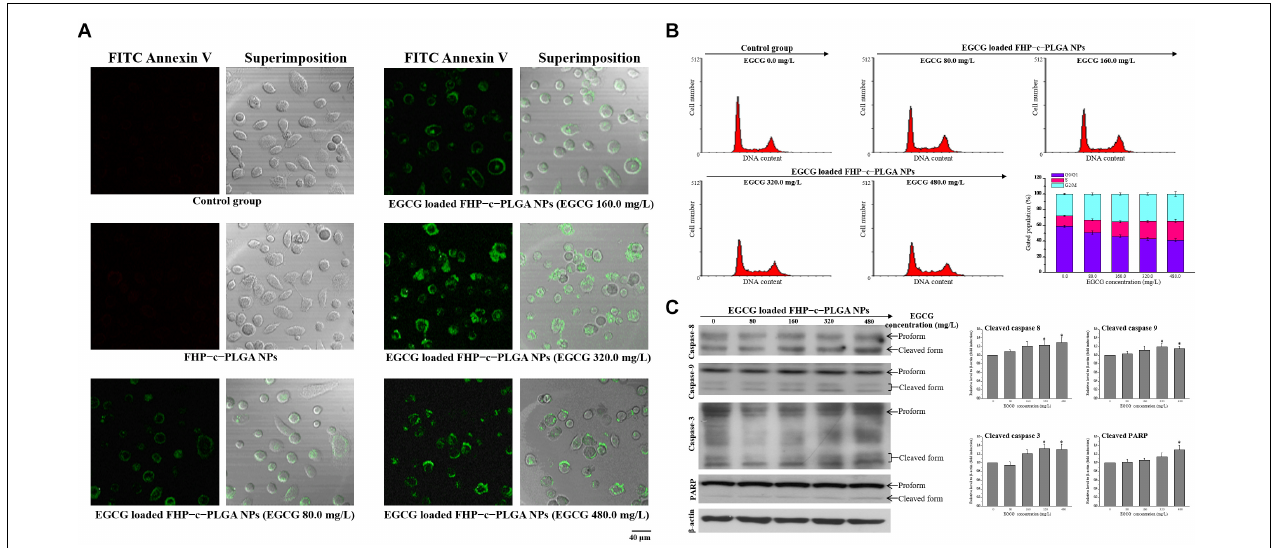
FIGURE 5 | (A) Fluorescence detection of apoptotic prostate cancer cells (PC3) cells after treatment with FHP–c–PLGA NPs loaded with different epigallocatechin gallate (EGCG) concentrations. Controls were labeled with FITC-Annexin V and analyzed using a con-focal laser scanning microscope. (B) The proportions of cells in the G0/G1, S, and G2/M phases after treatment with EGCG-loaded FHP-c-PLGA NPs are indicated. The cells were stained with propidium iodide, and the cell cycle distribution was analyzed using flow cytometry. (C) Western blotting analysis of apoptosis-related caspase-8, -9, -3, and poly (ADP-ribose) polymerase (PARP) in PC3 cells after incubation with EGCG-loaded FHP–c–PLGA NPs, and β -actin was used as an internal control. Asterisk * represents statistically a significant difference of p value < 0.05, as compared with the without sample treatment group. TABLE 3 | Effect of different PLGA/IO concentrations on particle sizes, polydispersity indices, and zeta potential values of the FHP-c-PLGA/PLGA/IO NPs ( n = 5). PLGA:IO (mg/mL) Mean Particle Size (nm) Polydispersity indices Zeta Potential Value (mV) FU/HA/PG concentration at 1.2:1.2:1.2 (mg/mL) 2.00:0.05 232.64 ± 13.87 PLGA, poly (D,L-lactide-co-glycolide); NPs,